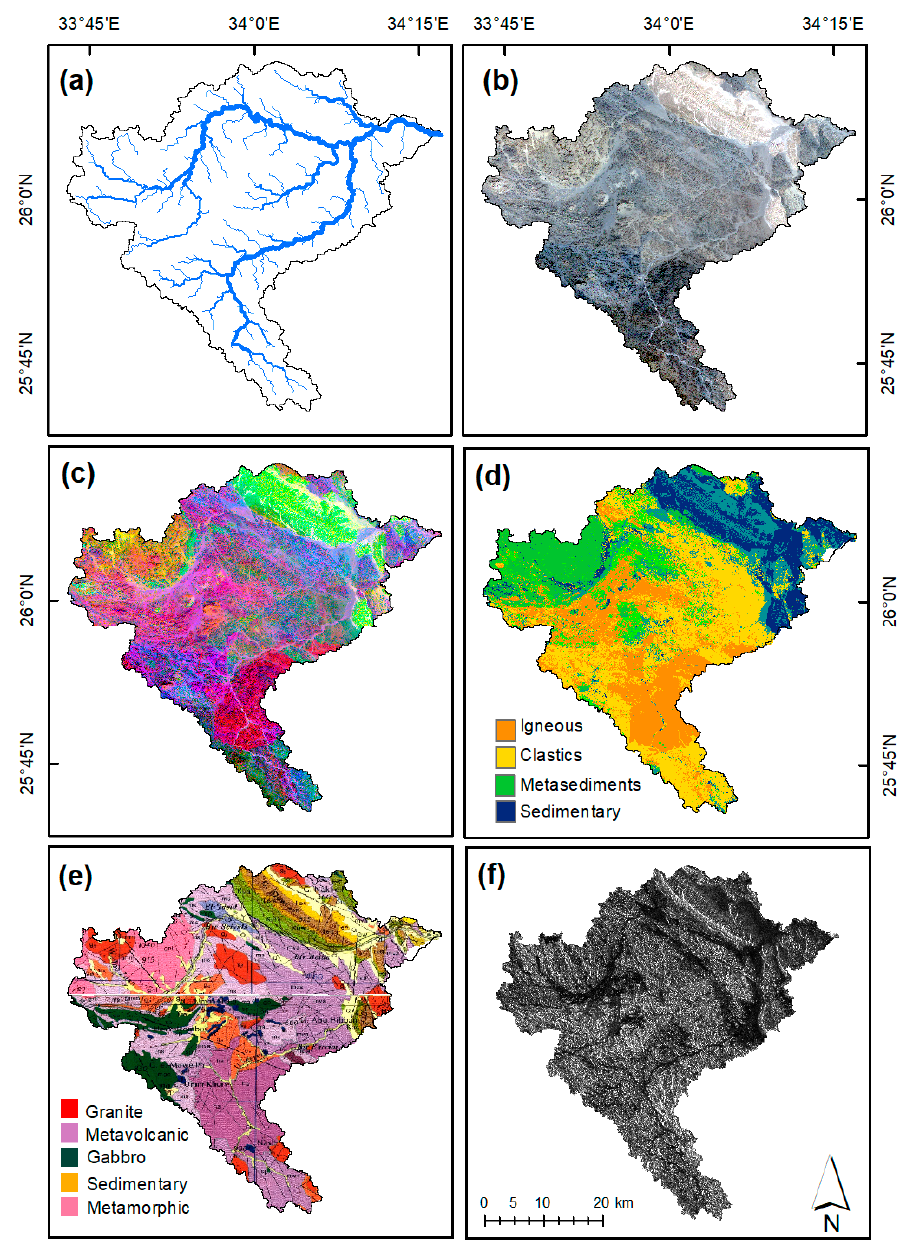
Figure 3. Hydrological and surface properties of Wadi El-Ambagi watershed: ( a ) Drainage basin and stream network of Wadi El-Ambagi, ( b ) ASTER color composite mosaic (bands 3, 2, and 1), ( c ) Aster derived Minimum Noise Fraction (MNF) image, ( d ) Land cover map derived from hybrid image classification, ( e ) 1: 500,000 geological map and ( f ) ALOS-PALSAR mosaic for the drainage basin.